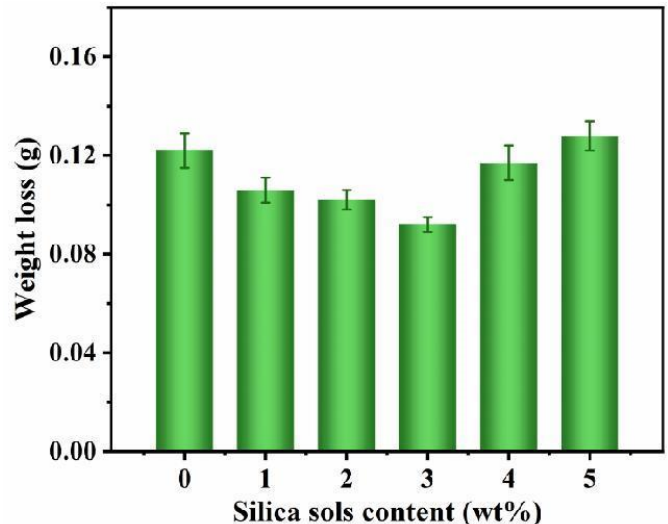
Figure 4. Effect of silica sol content on the abrasion resistance of UV-curable WA coatings.